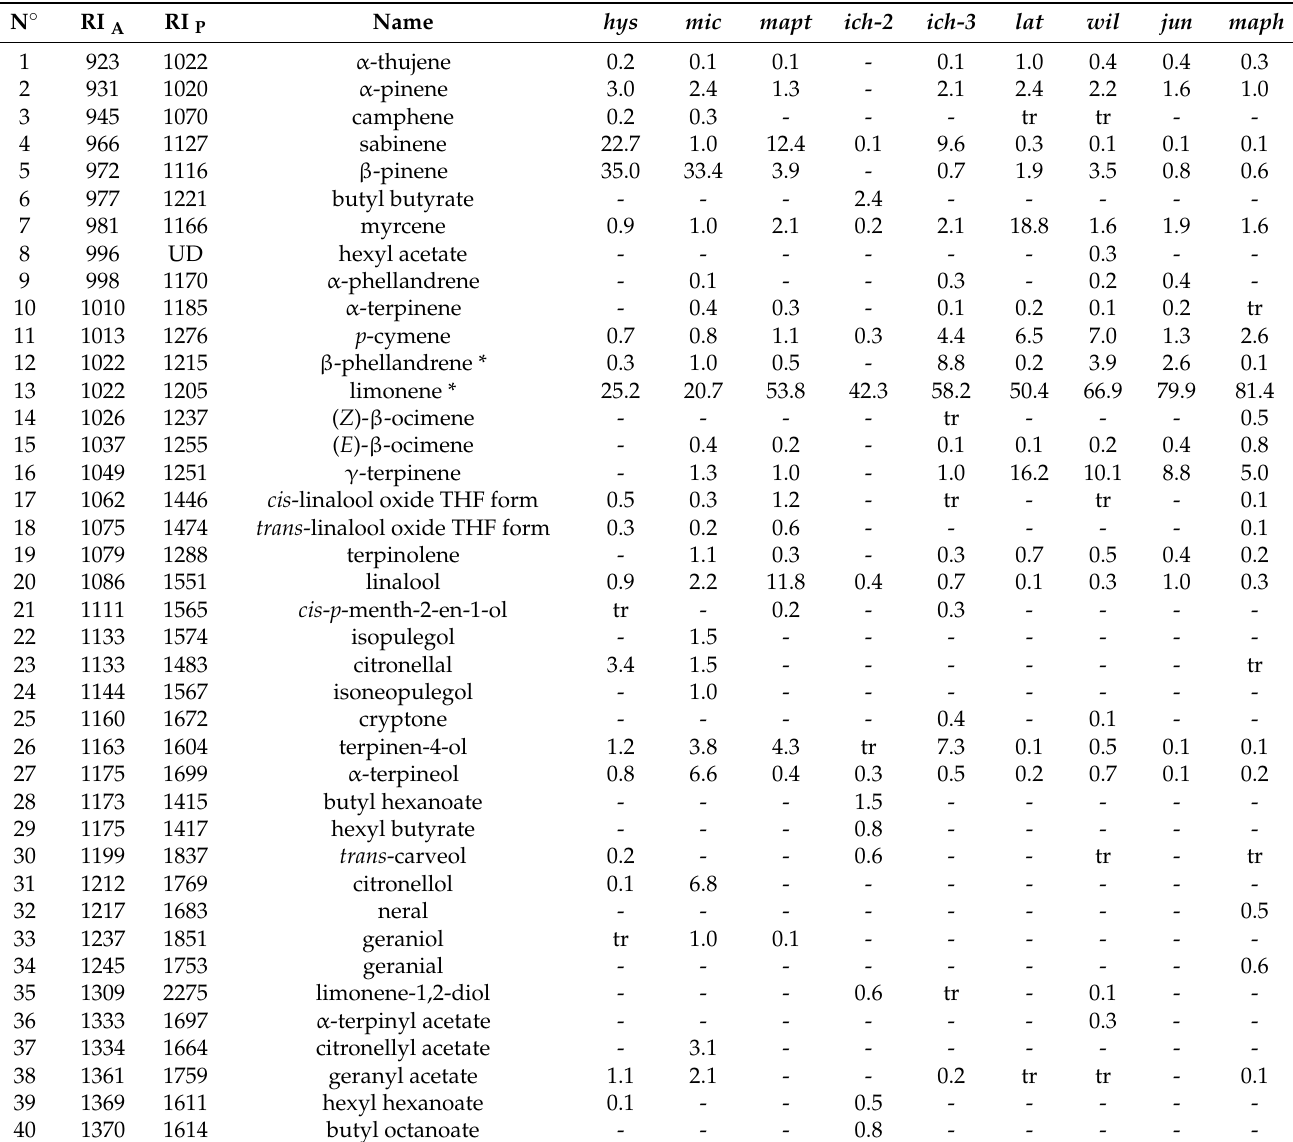
Table 1. Chemical composition of peel essential oils of nine Papeda oil